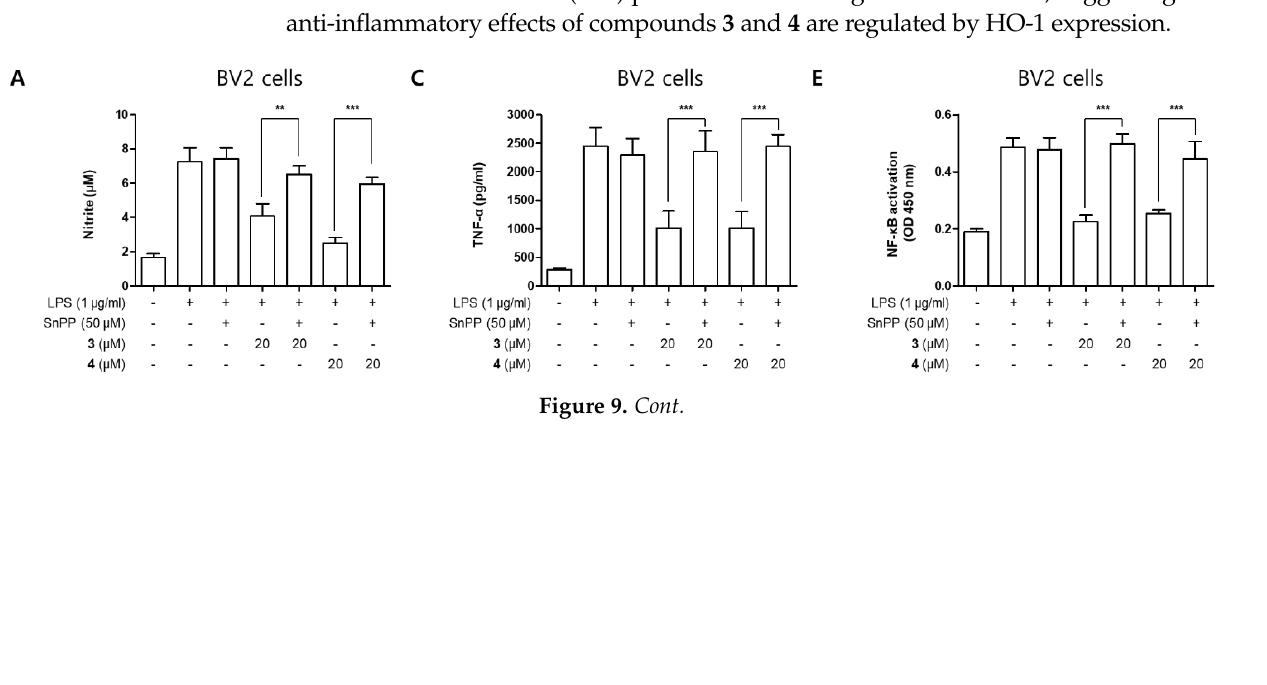
Figure 9. Inhibitory effects of compounds 3 and 4 on nitrite production through the regulation of HO-1 activity in BV2 ( A , C , E ) and RAW264.7 ( B , D , F ) cells. The cells were treated with 50 μM of tin protoporphyrin-IX (SnPP) or compounds 3 or 4 and stimulated for 24 h with lipopolysaccharide (LPS; 1 μg/mL). Data are presented as mean ± standard deviation of three independent experiments. ** p < 0.01 and *** p < 0.001. 3. Discussion The present study demonstrated that kuwanon T and sanggenon A exert suppressed LPS-induced inflammation in BV2 and RAW264.7 cells. These compounds inhibited the LPS-induced production of NO, PGE 2 , and pro-inflammatory cytokines, including IL-6 and TNF- α, and the expression of iNOS and COX -2 in both BV2 and RAW264.7 cells. These results indicated that kuwanon T and sanggenon A exerted their anti-inflammatory effects by inactivating the NF- κB signal ing pathway. In addition, these compounds in- duced the expression of HO-1 through the activation of Nrf2. In addition, these com- pounds induced the expression of HO-1 via Nrf2 activation, and this effect was also con- firmed to be related to the anti-inflammatory activity. Nitric oxide synthase (NOS) has three isoforms: neuronal NOS (nNOS; NOS1), iNOS (NOS2), and endothelial eNOS (NOS3) [32]. iNOS is an inducible form that is upregulated in response to various stimuli, including LPS, cytokines, chemokines, and stress, while nNOS and eNOS are constitutive forms that catalyze continuous NO secretion at basal concentrations [33]. Similar to iNOS, COX-2 is also an inducible form upregulated by var- ious inflammatory stimuli, such as cytokines, growth factors, tumor promoters, and bac- terial LPS [34]. Its other isoform, COX-1, is constitutively expressed in most tissues under normal physiological conditions [35]. COX-2 exerts an enzymatic effect on the conversion of prostaglandin H2 (PGH2), which converts arachidonic acid to PGE 2 , prostaglandin I2 (PGI2), prostaglandin F2α (PGF 2α ), and thromboxane A2 (TXA 2 ) [36]. Under inflammatory conditions, the levels of iNOS and COX-2 increase, resulting in the overproduction of NO and PGE 2 , respectively, and leading to the exacerbation of inflammatory disorders [37]. In the present study, we first evaluated 11 compounds isolated from M. alba to determine whether NO production is inhibited in LPS-stimulated in BV2 and RAW264.7 cells. Our results showed that kuwanon T and sanggenon A exerted the strongest inhibitory effects in both BV2 and RAW264.7 cells (Figure 3). In our previous study, moracin M had anti-